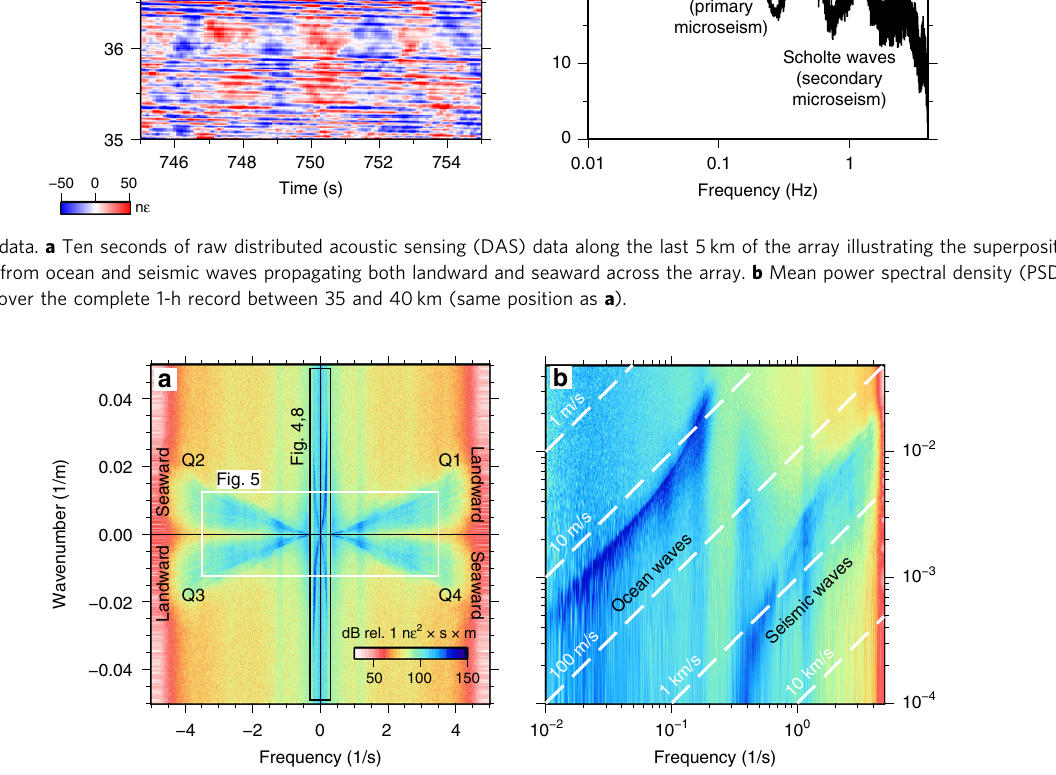
Fig. 3 Separation of ocean and seismic waves. a Raw frequency – wavenumber power spectrum of 1 h of strain data across the full 42-km array. b Quadrant 1 (landward-propagating waves) plotted in logarithmic space, showing coherent ocean wave energy at low frequencies and coherent seismic wave energy at high frequencies. Dashed white lines are plotted along contours of constant phase velocity ( c ¼ f = k